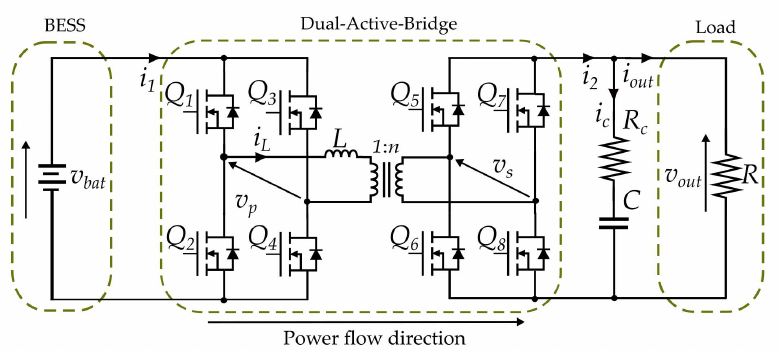
Figure 2. DAB converter circuit for battery energy storage system (BESS) connected to DC